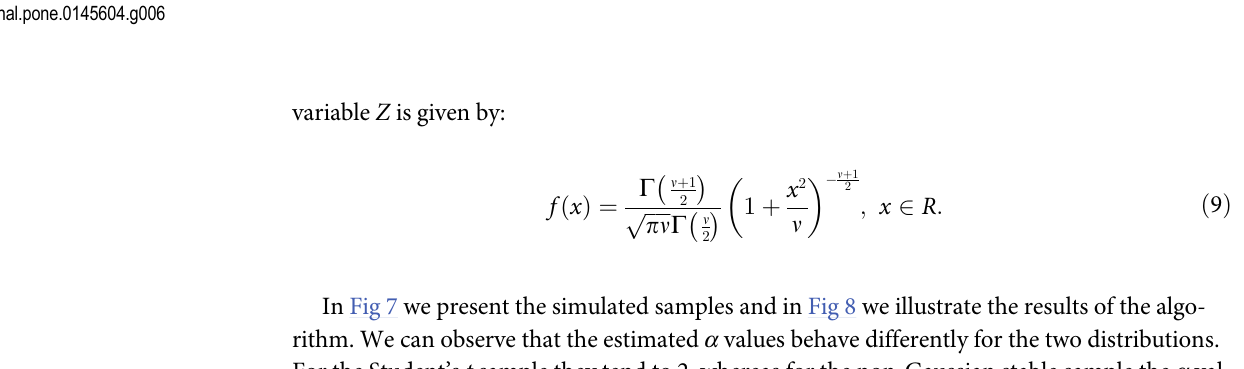
Fig 6. Estimated α values for the square Gaussian sample from the top left panel of Fig 5 (top panel) and for the stable sample from the top right panel of Fig 5 (bottom panel). The box plots were constructed from 100 bootstrap samples of length 2000.